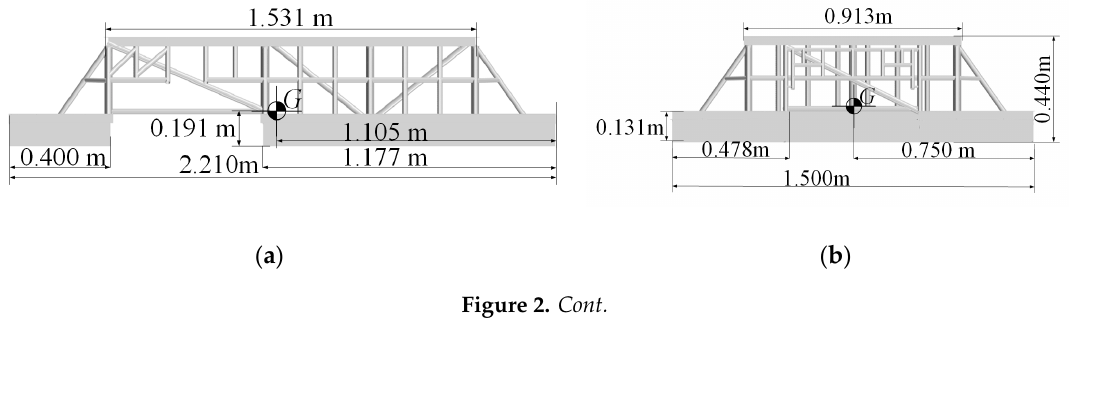
Figure 1. Photograph of the physical model.